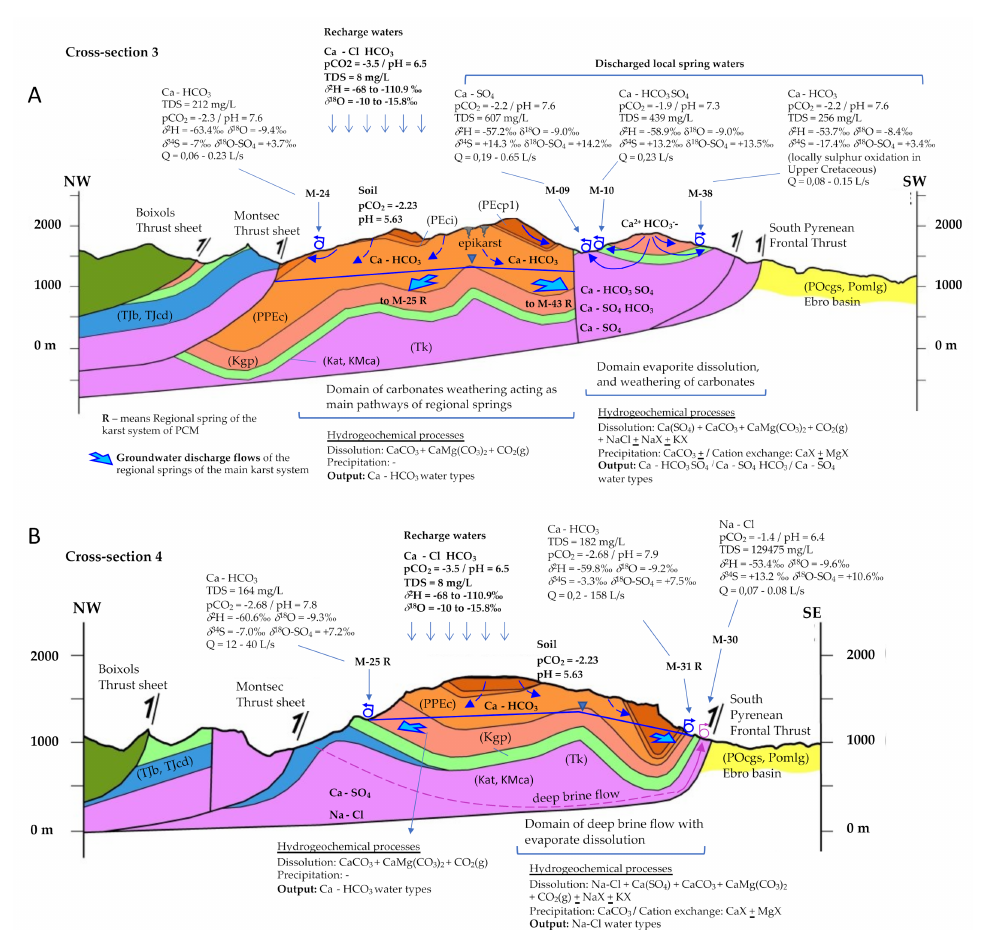
Figure 14. Hydrogeological-hydrogeochemical conceptual models corresponding to the cross-section 3 ( A ) and 4 ( B ). The sketch shows the closest springs, projected in the